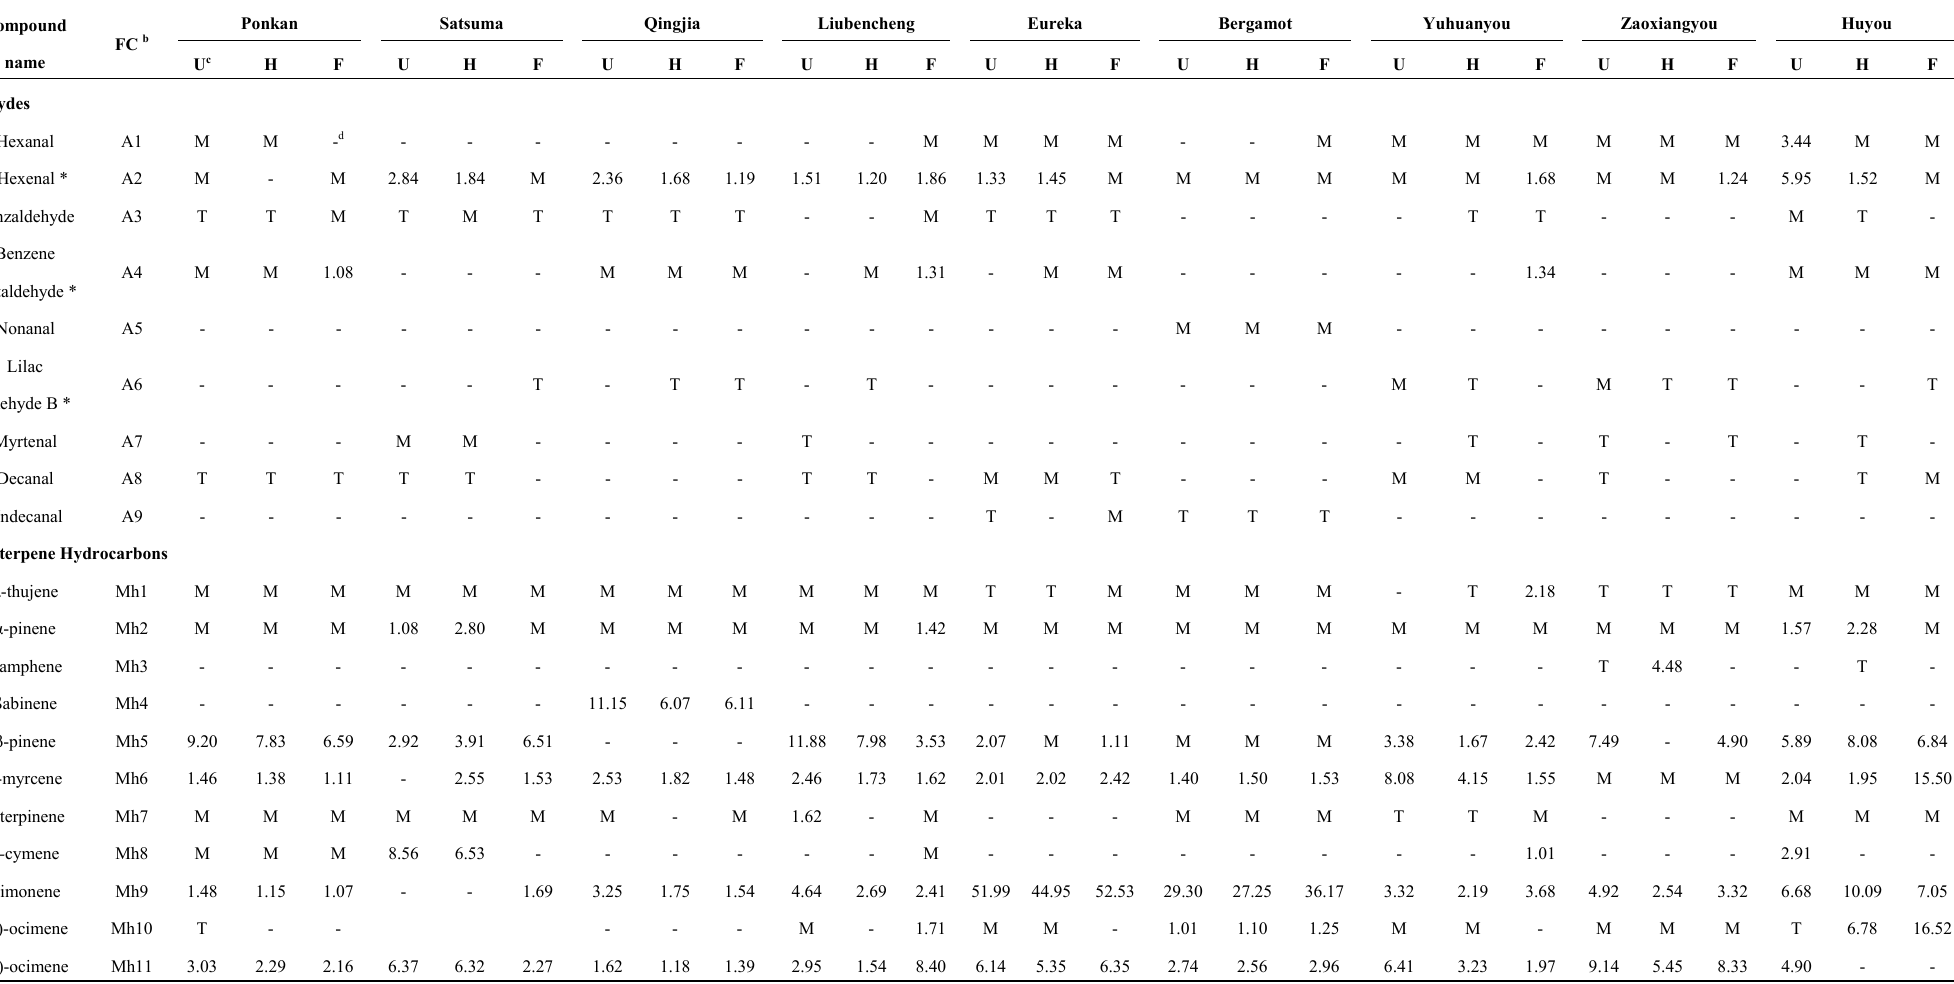
Table 2. Identification of flower volatiles and quantification of their abundance by percentage in unopened, half opened and fully opened flowers from five citrus